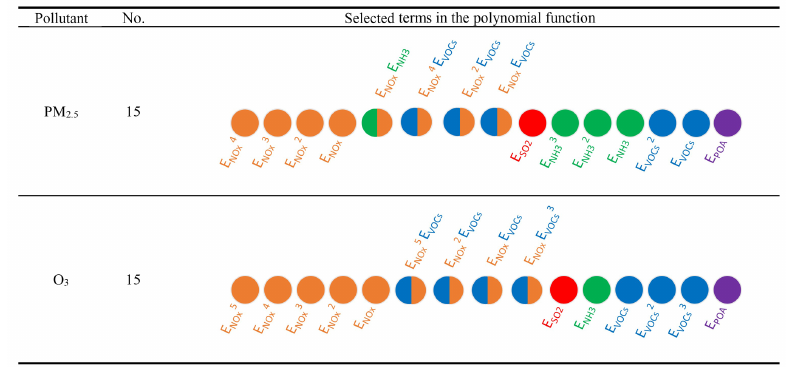
Figure 4. Term selections for PM 2 . 5 and O 3 in the polynomial